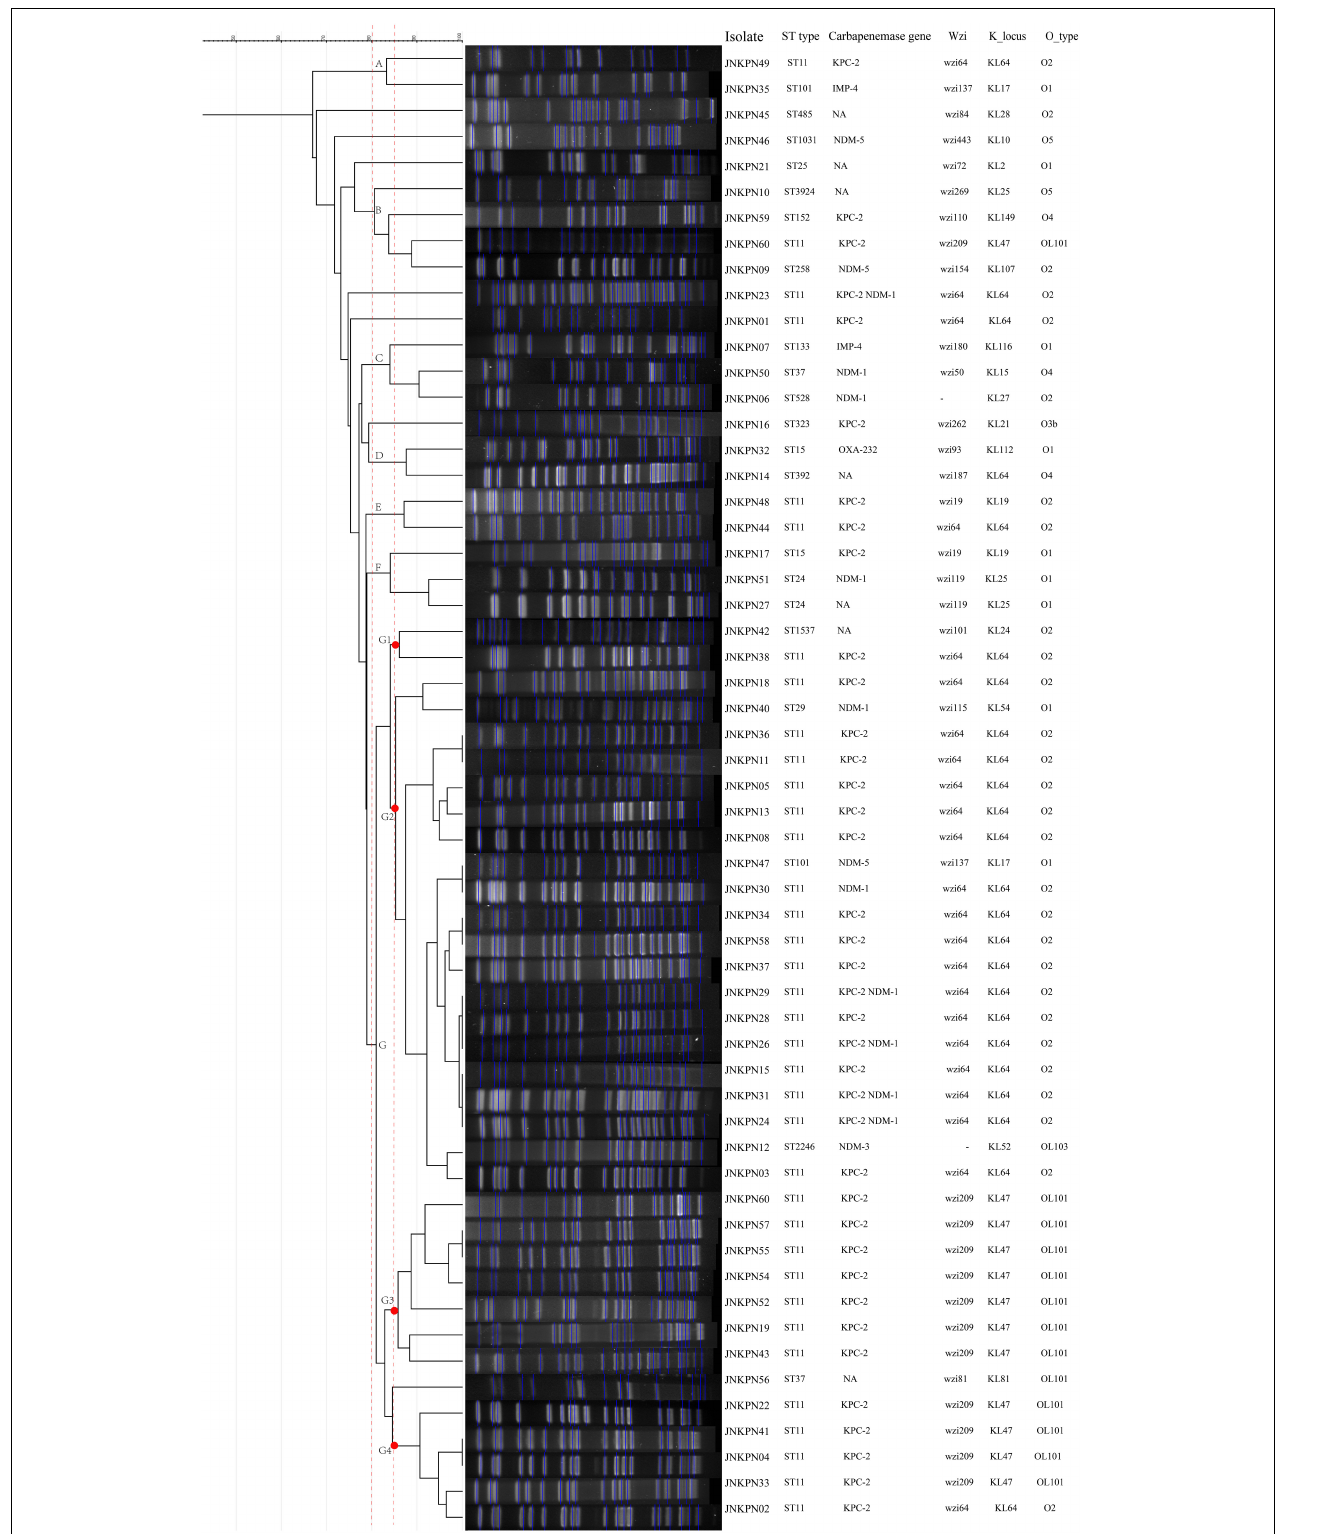
FIGURE 1 | The dendrogram is based on the similarity of pulsed-field gel electrophoresis (PFGE) patterns in the 57 clinical carbapenem-resistant Klebsiella pneumoniae (CRKP) isolates. The right panel shows results from isolate name, sequence type, carbapenemase gene, K_locus, and O_type. NA, not available.